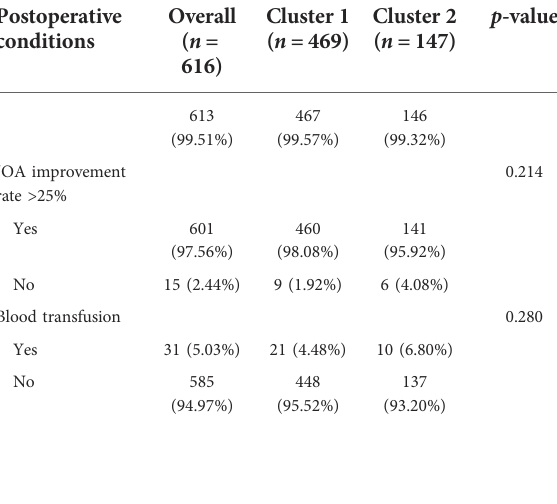
TABLE 3 Postoperative conditions of two clusters of